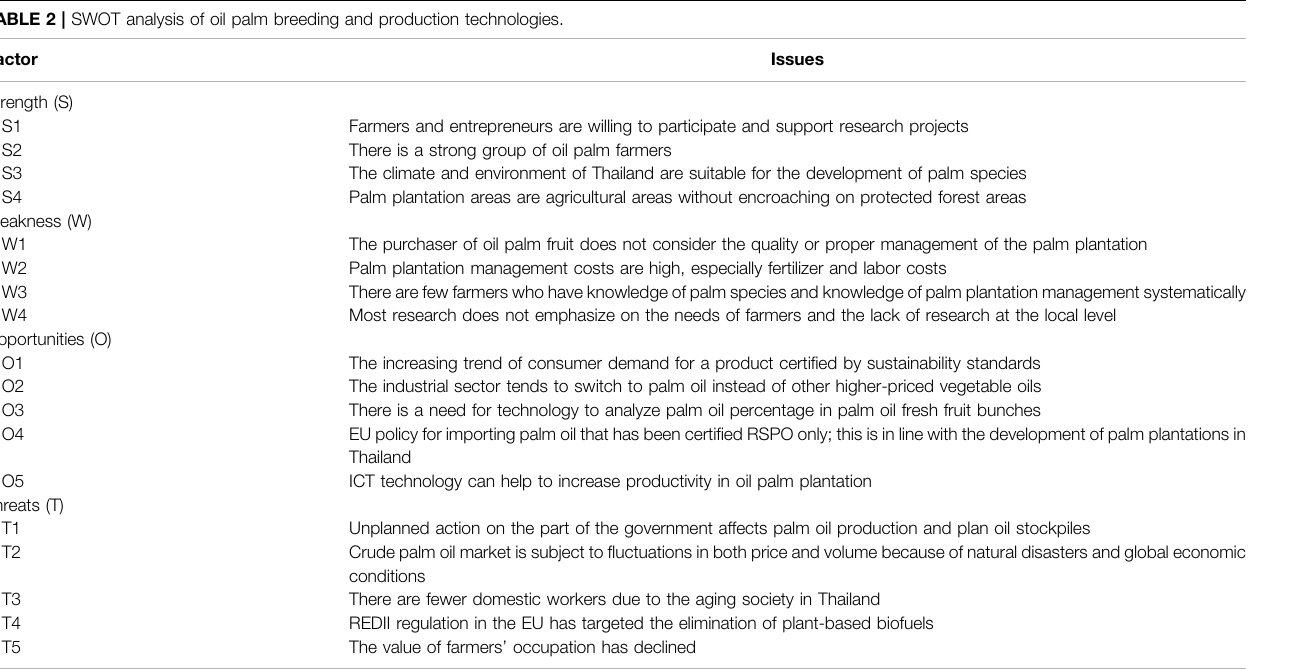
TABLE 2 | SWOT analysis of oil palm breeding and production